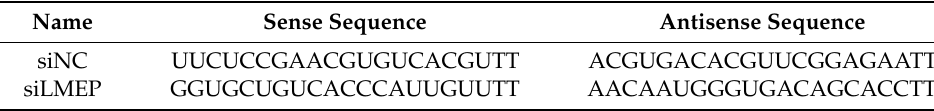
Table 1. siRNA sequences of LMEP